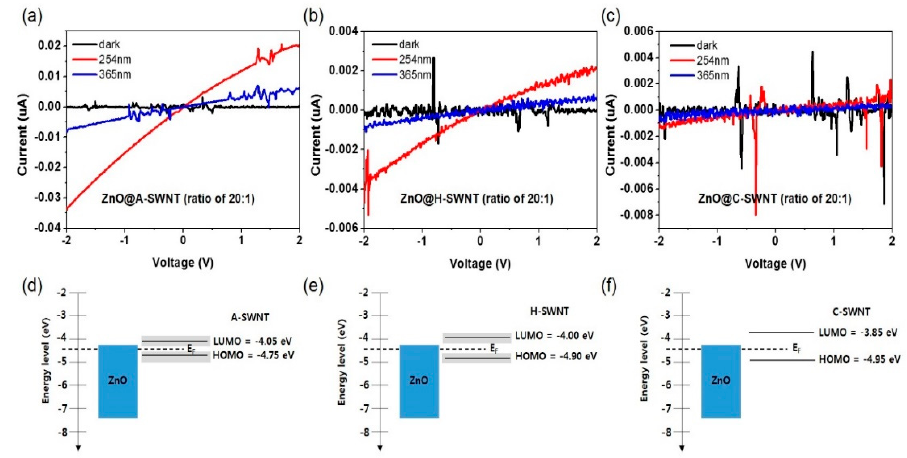
Figure 8. I–V curves for ( a ) ZnO@A-SWNT, ( b ) ZnO@H-SWNT, and ( c ) ZnO@C-SWNT(ZnO/SWNT = 20:1, w/w) under 254 and 365 nm UV light illumination (0.47 mW/cm 2 ). Energy band diagram of ( d )